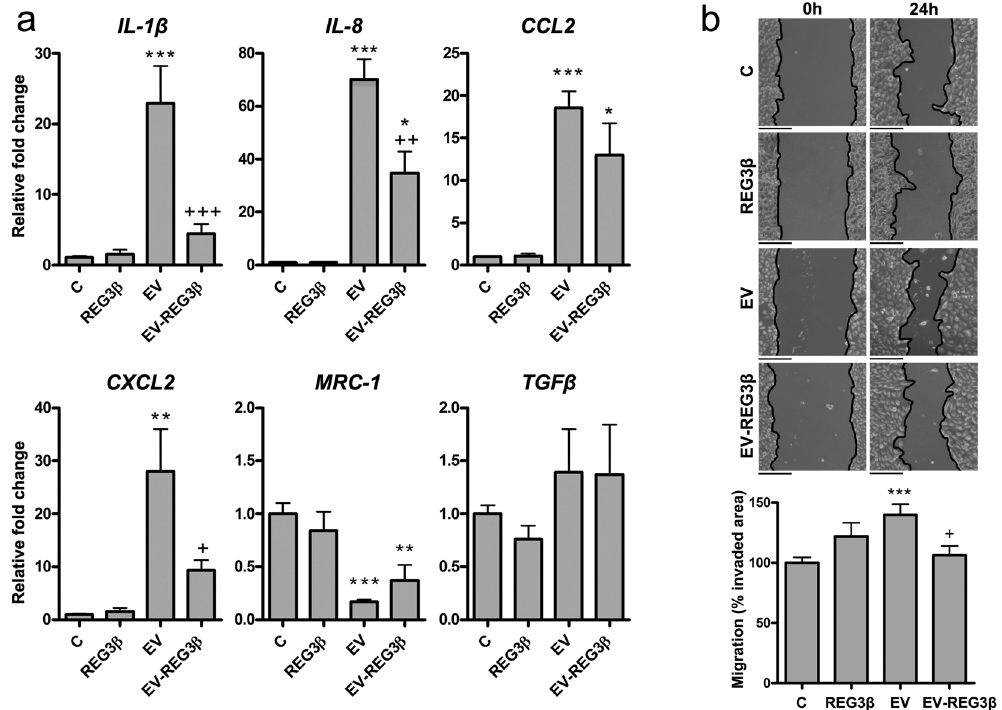
Figure 3. EVs blocked by REG3 β lose their capability to modulate some cell functions. ( a ) qPCR analysis of different pro-inflammatory (IL-1 β , IL-8, CCL2, CXCL2 ) and anti-inflammatory/regulatory ( MRC-1, TGF β ) markers on THP-1 macrophages treated with 500 ng/ml of REG3 β , and 3 µ g/ml of MPC-EVs (EV) or REG3 β - blocked MPC-EVs (EV-REG3 β ) for 24 h (n = 6). Data are depicted as relative expression to the GAPDH housekeeping gene. ( b ) Scratch-wound healing assay of MIA PaCa-2 cells incubated with 500 ng/ml of REG3 β , and 3 µ g/ml of THP1-EVs (EV) or REG3 β -blocked EVs (EV-REG3 β ) for 24 h (n = 6). Down, quantification of cell migration. Scale bars: 200 µ m. In all panels, data are expressed as mean ± SEM. ANOVA with Tukey’s post- test was used to calculate P -values. * P < 0.05, ** P < 0.01, *** P < 0.001 compared to non-treated (C), + P < 0.05, ++ P < 0.01, +++ P < 0.001 compared to